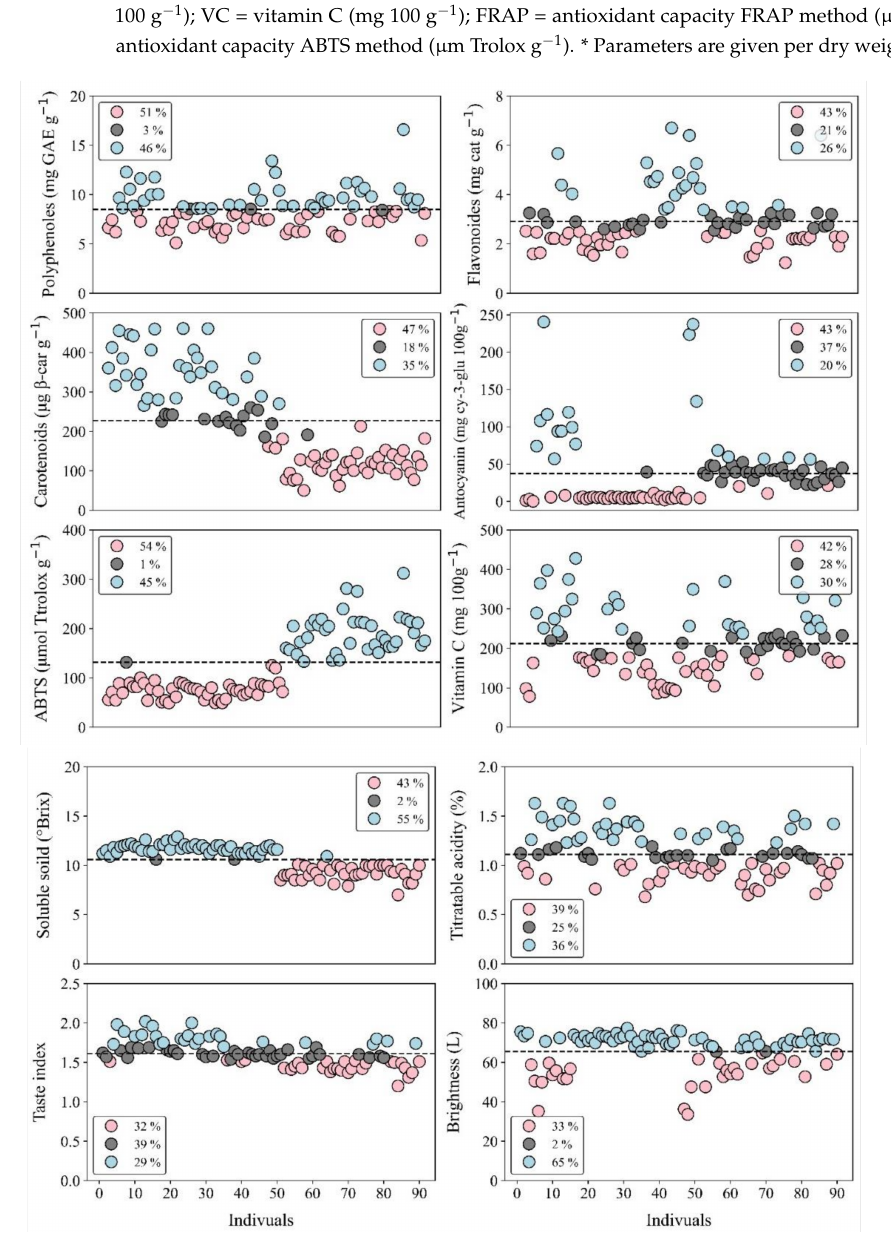
Figure 1. Data variability observed in some relevant traits from the tree tomato breeding population. Red color represents the low category, black the medium category and blue the high category (Table 2). The percentage of individuals belonging to each category is shown in the legend of each trait. The dotted line indicates the